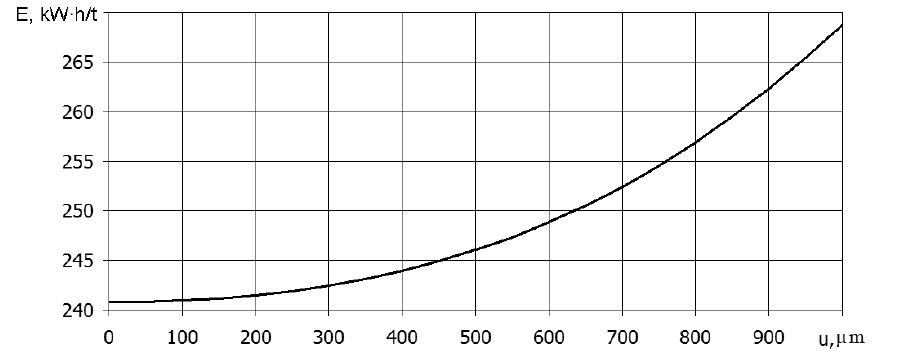
Fig. 4. Increase in energy consumption of solid waste dehydration due to the auger